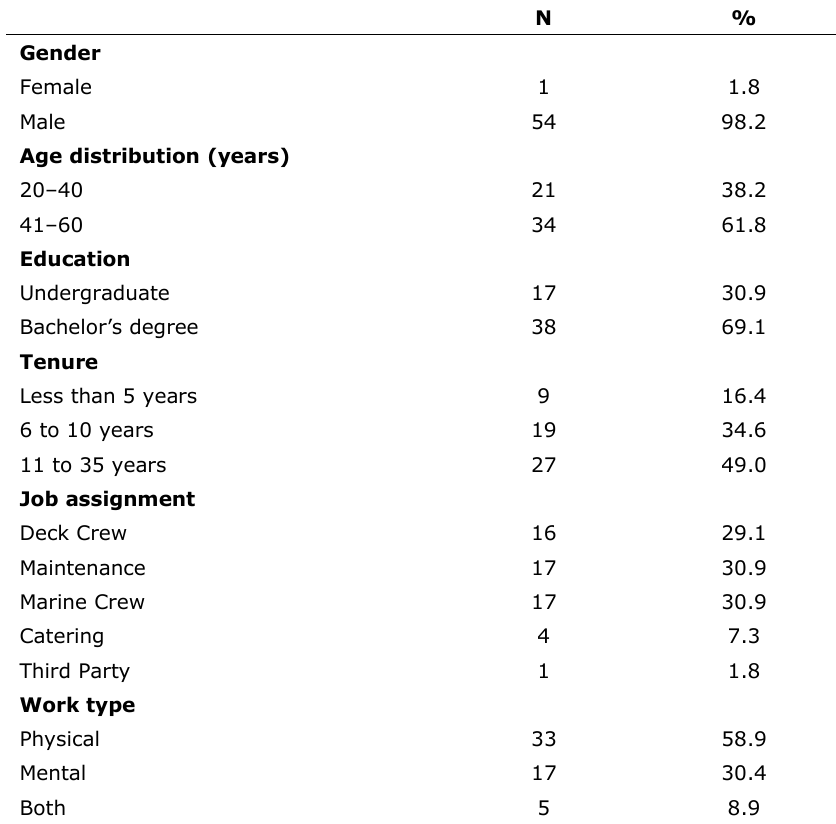
Table 1. Characteristics of the off-shore participants (n=55)